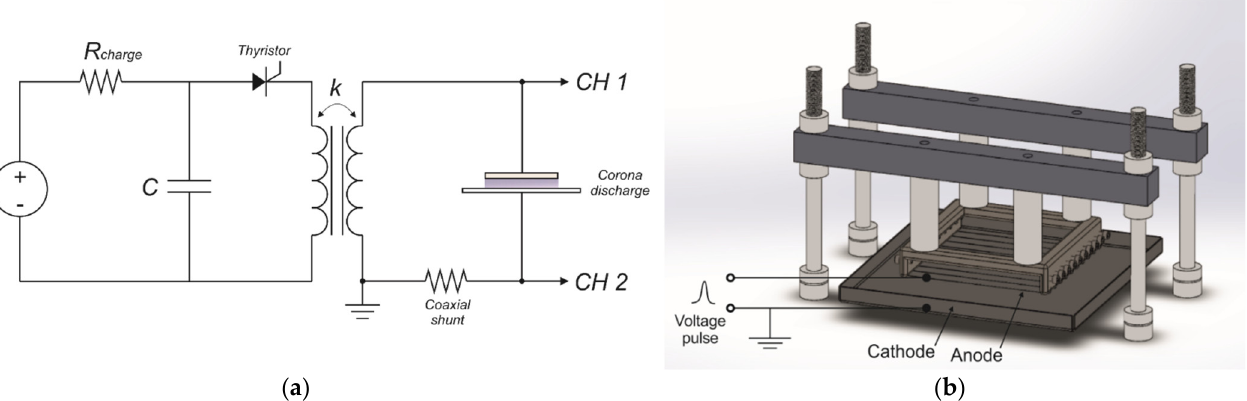
Figure 1. ( a ) Schematic of the capacitive pulsed source and electrical parameters measurement cir- cuit, ( b ) schematic of the plasma reactor. The anode consisted of 10 parallel wires spaced 10 mm apart and the cathode consisted of a stainless-steel reservoir containing the liquid in the form of a thin film.